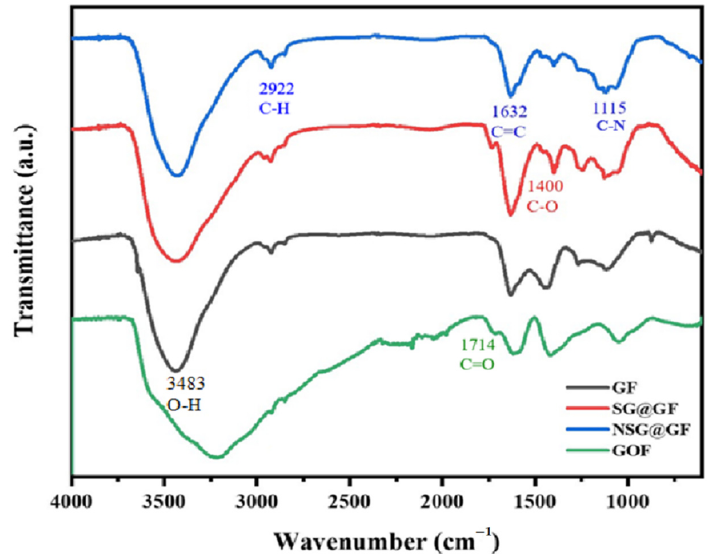
Figure 5. FTIR spectra of GOF, GF, SG@GF, and NSG@GF.